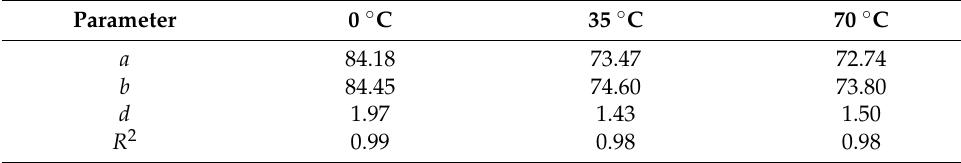
Table 4. Fitting parameters of cohesion degradation.